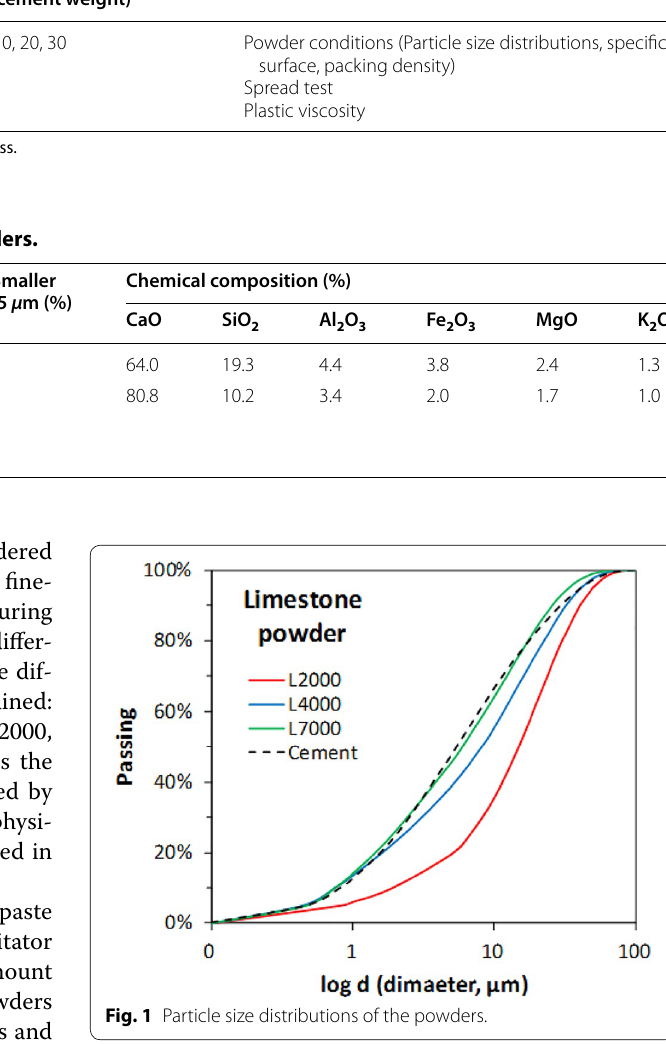
Table 1 Experimental plan. Mixture conditions